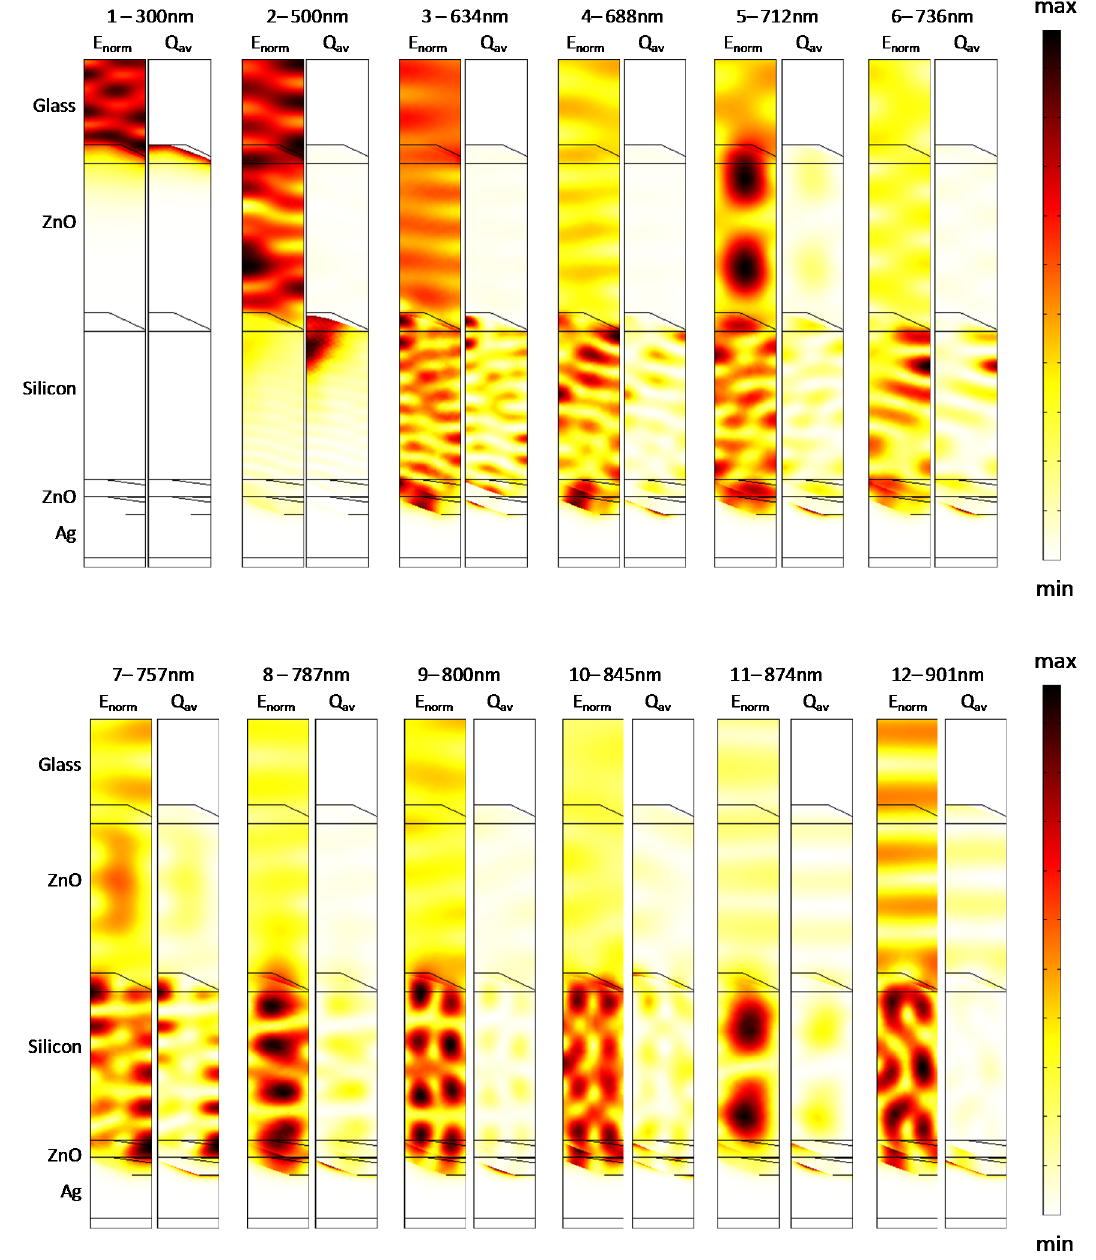
Figure 14. Normalized electric field and resistive heating field distributions along an orthogonal slice in the zx plane for the cells with an 800-nm-thick silicon layer at individual